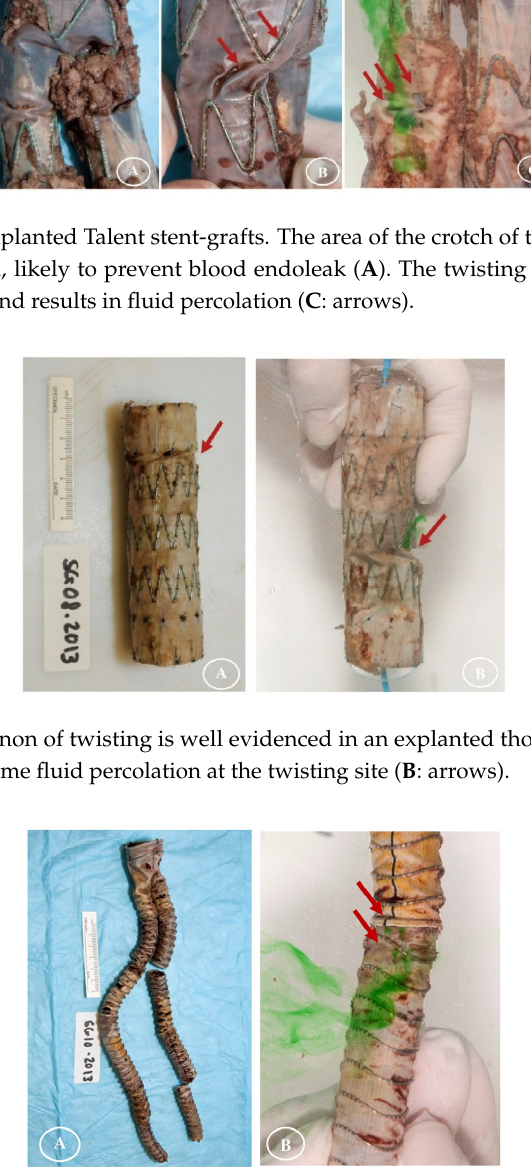
Figure 3. Deformation from twisting in the body of an explanted Anaconda device is maintained after explantation. The fabric preserves its imperviousness according to the gross observation ( A ). However, endoleaks were shown in the distal limb ( B ).